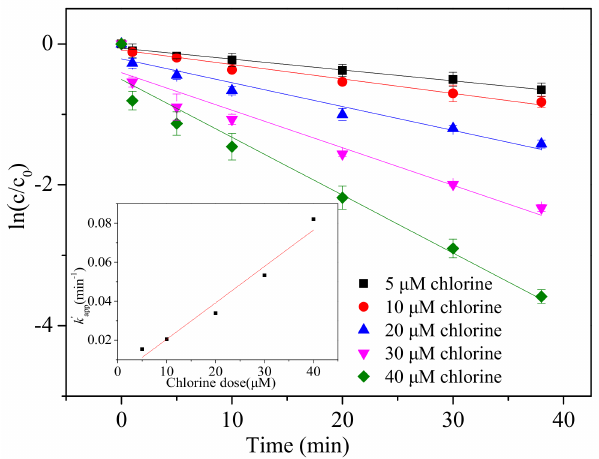
Figure 2. E ff ect of residual free chlorine on AML degradation by the UV / chlorine process ([AML] 0 = 10 µ M, UV intensity = 500 µ W · cm − 2 , pH =